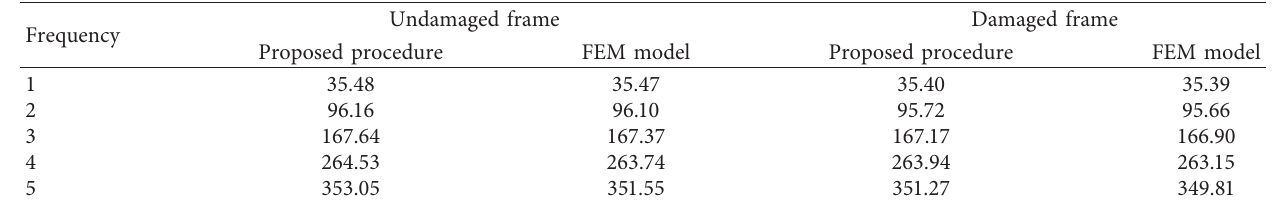
Table 3: Frequencies of undamaged and damaged